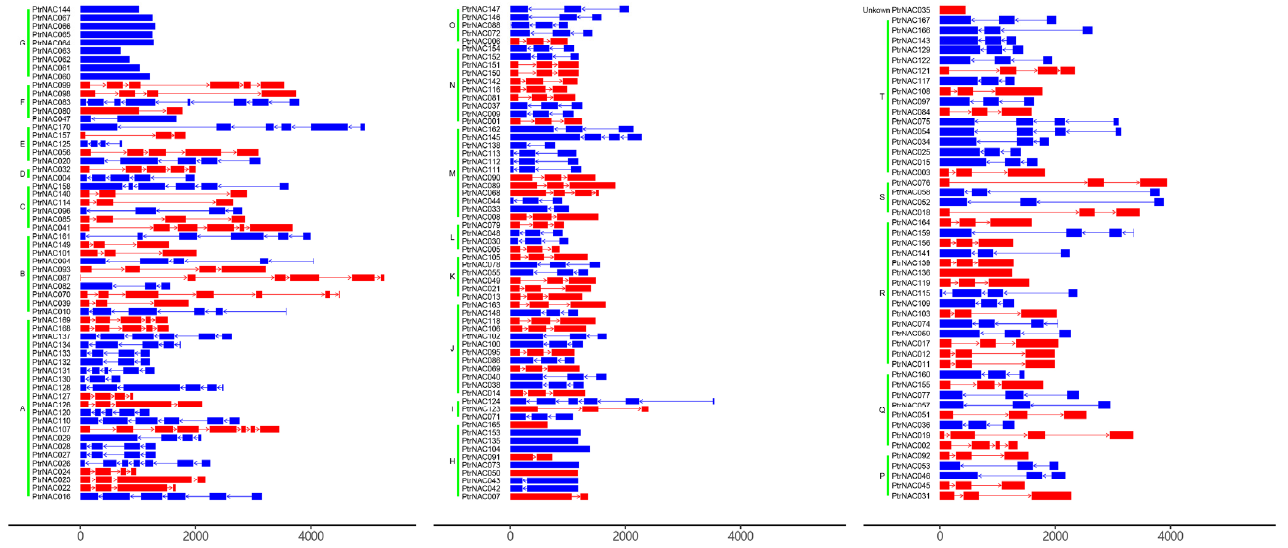
Figure 4. Gene structures of NAC genes in poplar. The plus-strand (+) and the minus-strand ( − ) of PtrNAC genes were marked in red and blue, respectively. Exon and intron of PtrNACs were indicated in a rectangle and line, respectively.